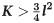
The retailer's profit and utility with β in K>34l2.